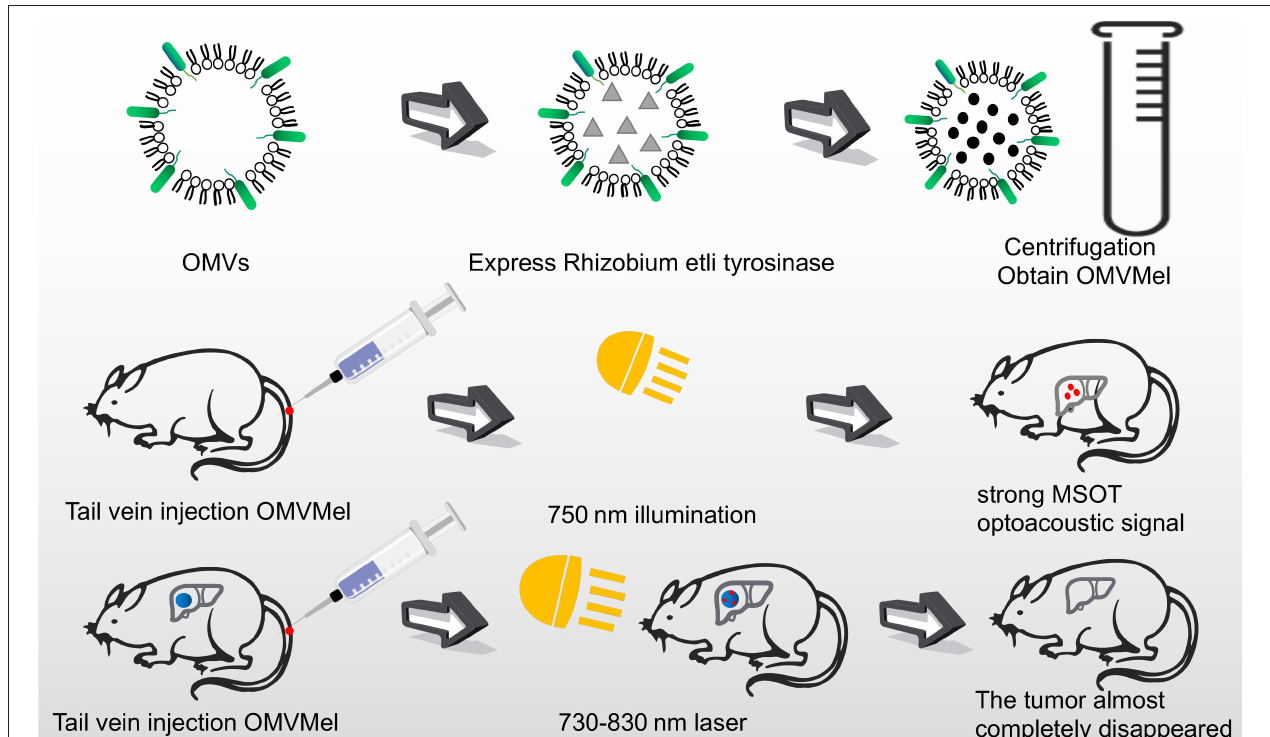
FIGURE 4 | OMVs loaded with melanin were injected into mice through the tail vein. After irradiating at 750nm, a strong photoacoustic signal of MSOT was generated. The tumor cells were almost completely killed by laser irradiation at 730–830nm for several minutes.